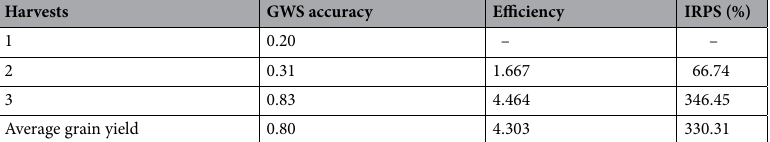
Table 2. Accuracy and efficiency of genomic selection compared to selection only with phenotypic data in Jatropha. IRPS: Increase relative to phenotypic